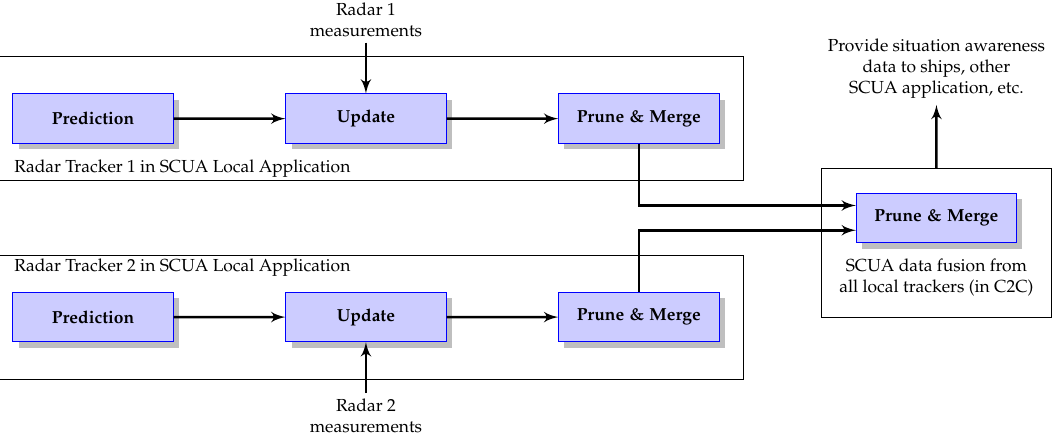
Figure 1. Probability Hypothesis Density ( PHD) filtering and data fusion implementation scheme (example of two sensors available).